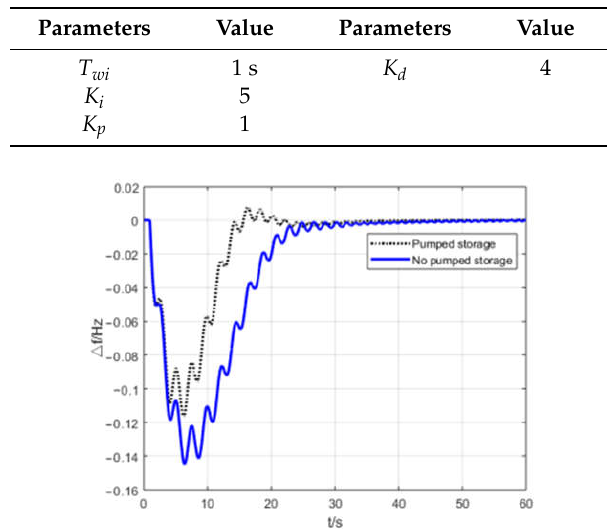
Table 4. Basic parameters of hydraulic turbine.